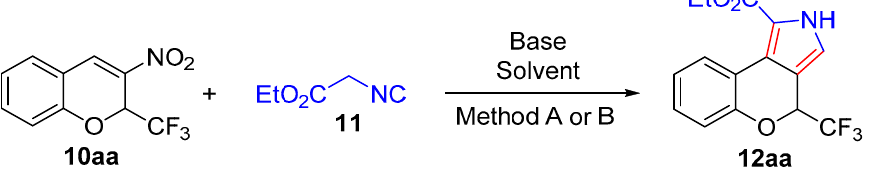
Table 1. Condition optimization for the reaction of 10aa with 11 a . Entry Base Equiv. Solvent 1 DBU 1.1 DBU 1.1 DABCO 1.1